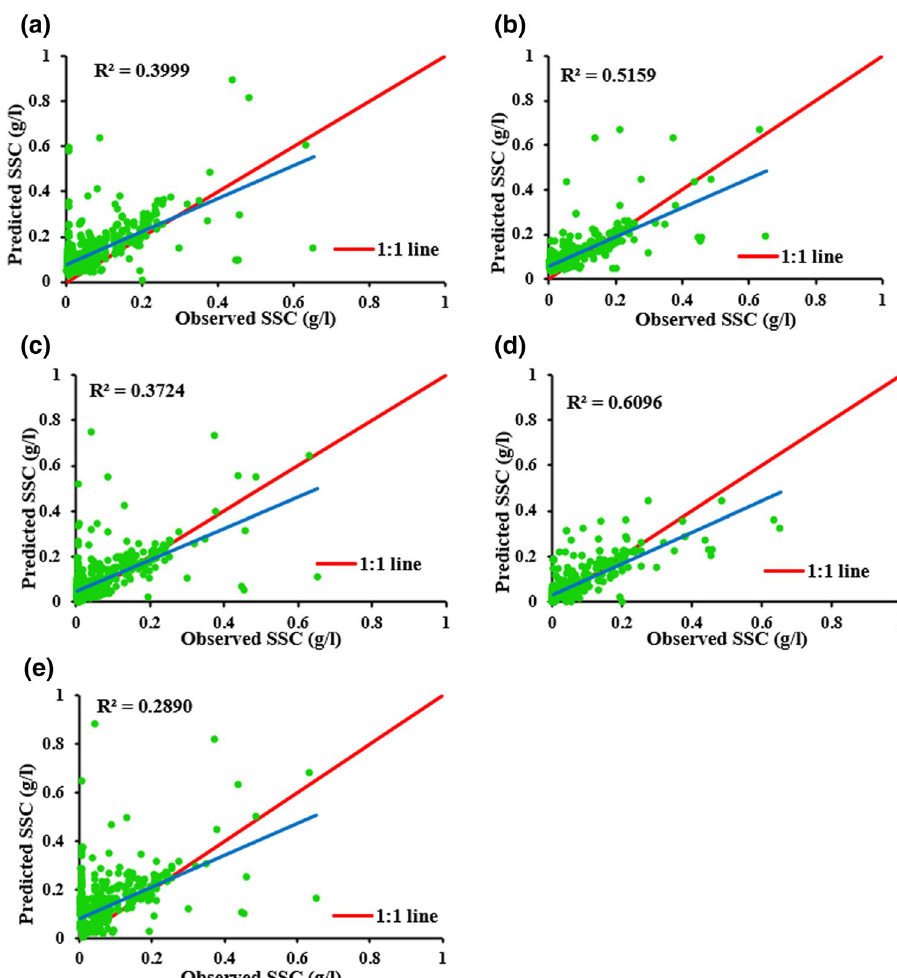
Fig. 9 Scatter plots of